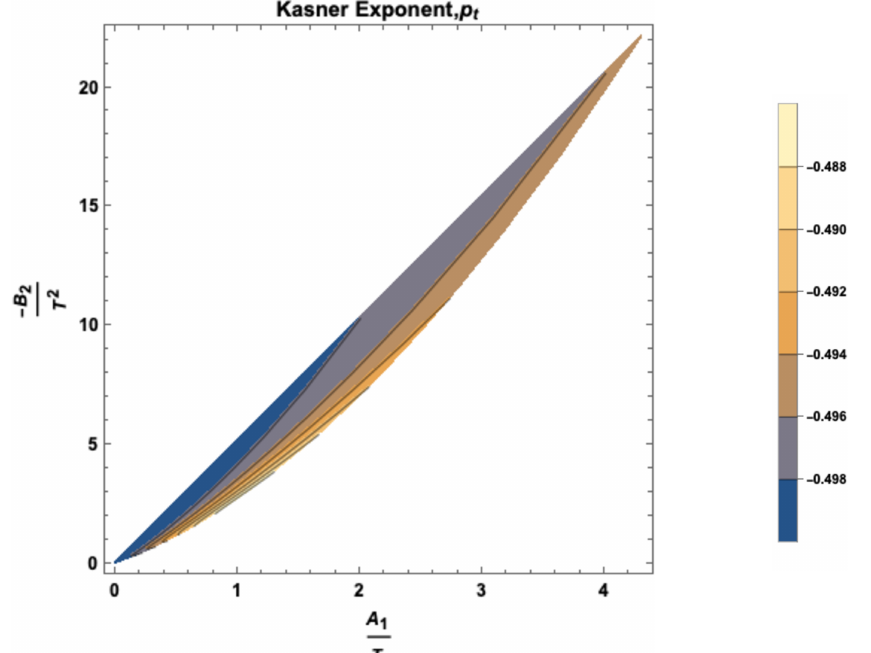
Figure 9. A contour plot showing how the Kasner exponent depends on the deformation parameters. This is obtained from the explicit numerical flow solutions constructed with the supergravity potential. Qualitatively, the Kasner exponent depends on the deformation in a similar manner that we have observed with the toy